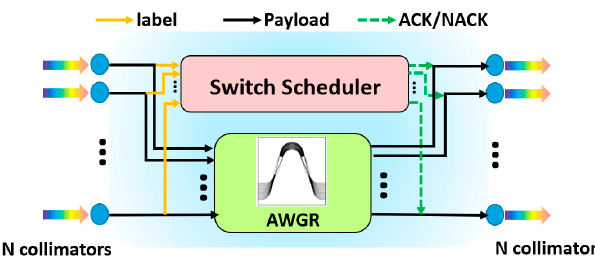
Figure 3. The functional blocks of ToR switch.